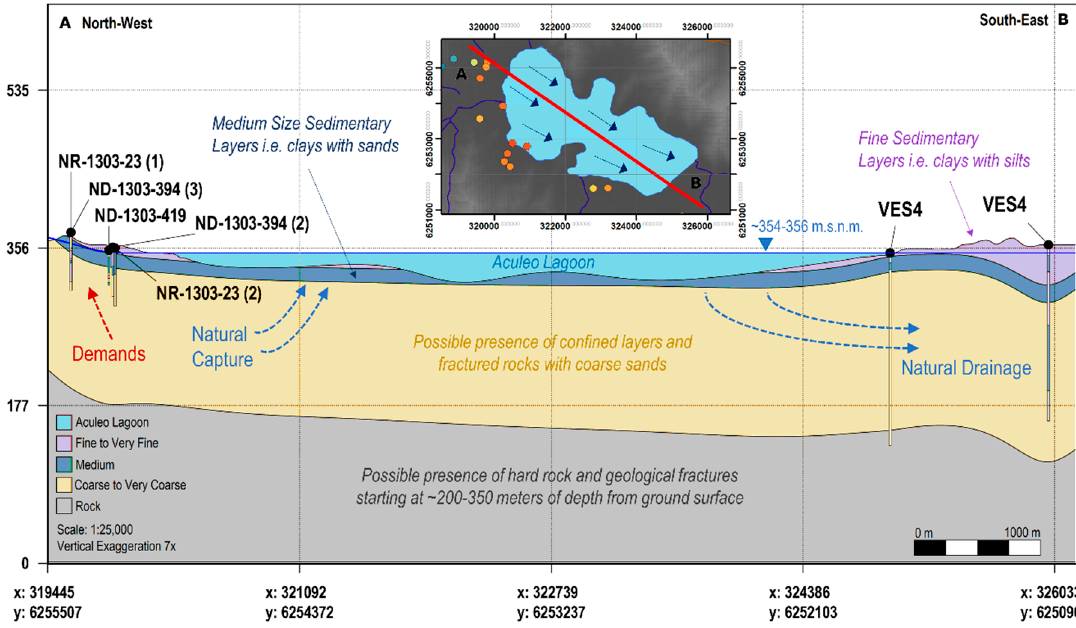
Figure 4. Cross-section along the Aculeo Lagoon (northwest to southeast). The main geological setting together with the hydrogeologic processes of the Lagoon are also conceptualized.